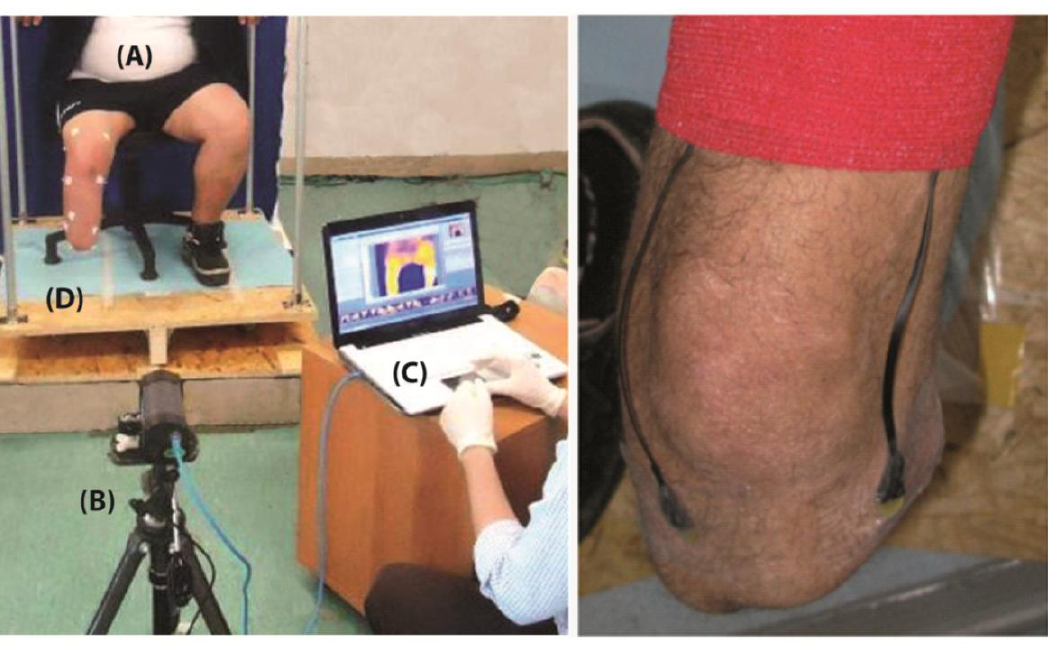
Figure 5. The experimental set-up (on the left): ( A ) the subject and his stump; ( B ) the IR camera for thermal map recording; ( C ) the PC for data processing; ( D ) a rotating platform for controlled image plane projections recording. The wearable sensor setup (on the